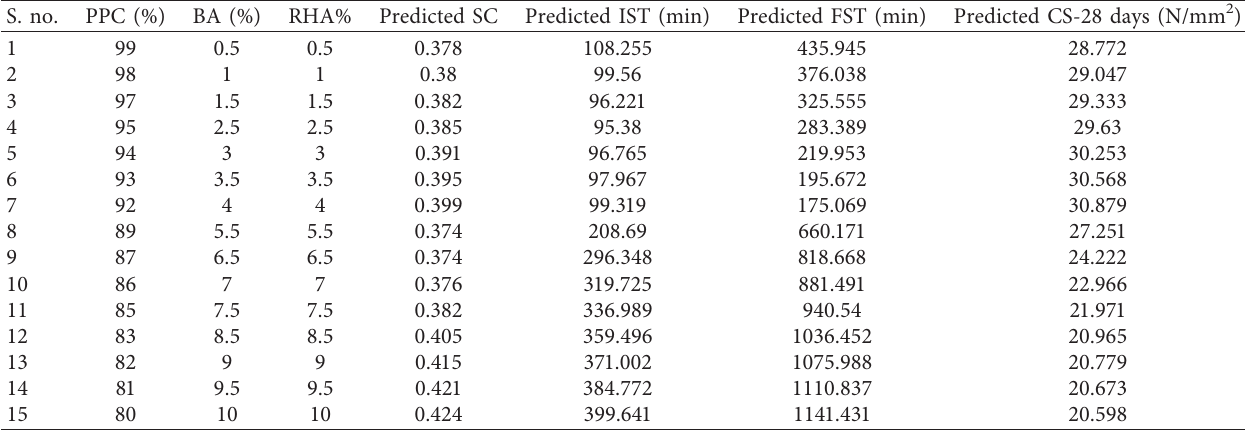
Table 8: Intermediate mix proposition of BA +RHA with PPC-test dataset of ANN3.